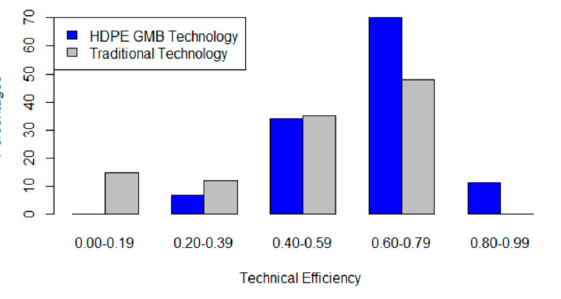
Figure 6. Distribution of technical efficiency indexes for the traditional technology and HDPE